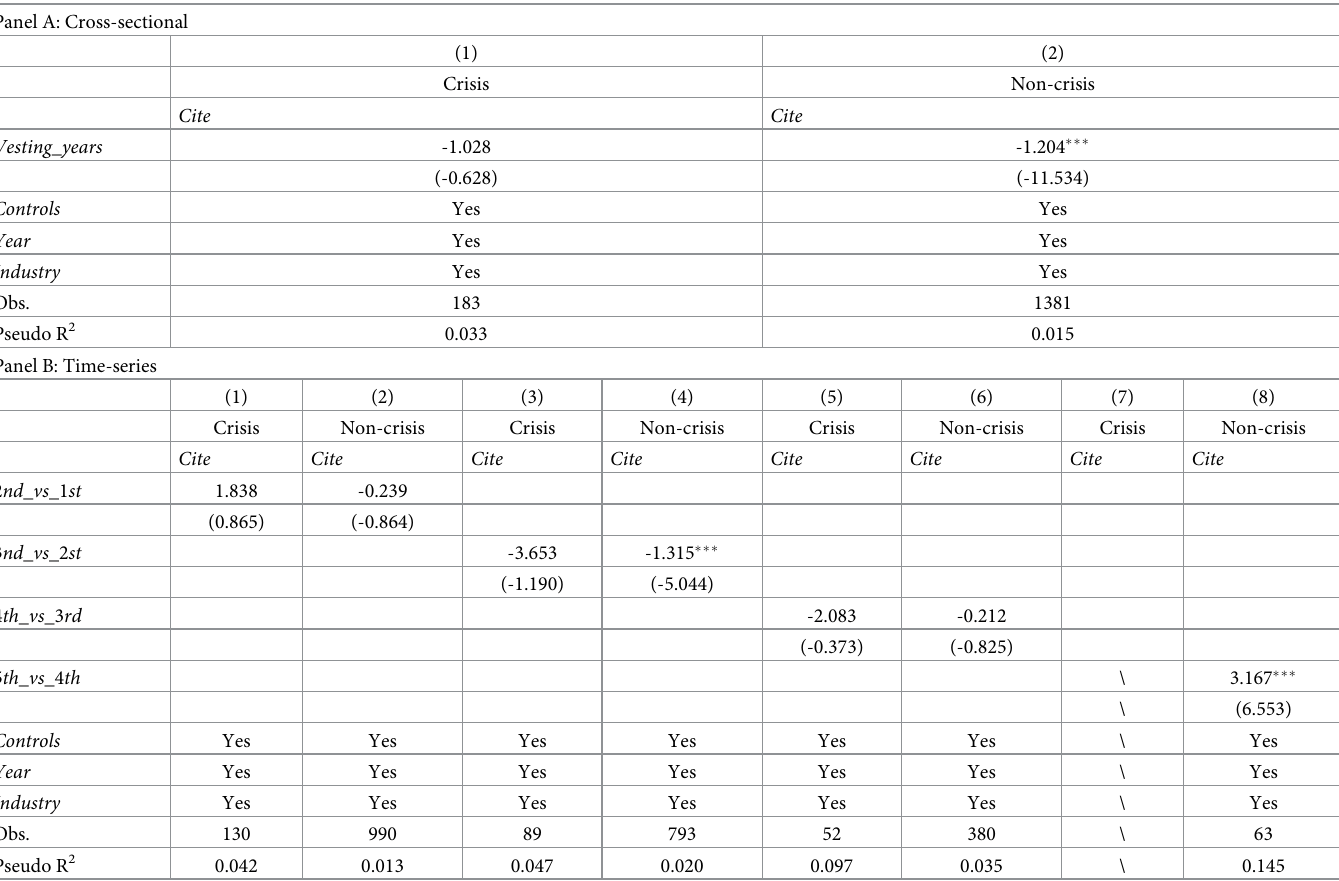
Table 7. Differences in the effects of vesting periods on exploratory innovation intensity: Financial crisis. Panel A: